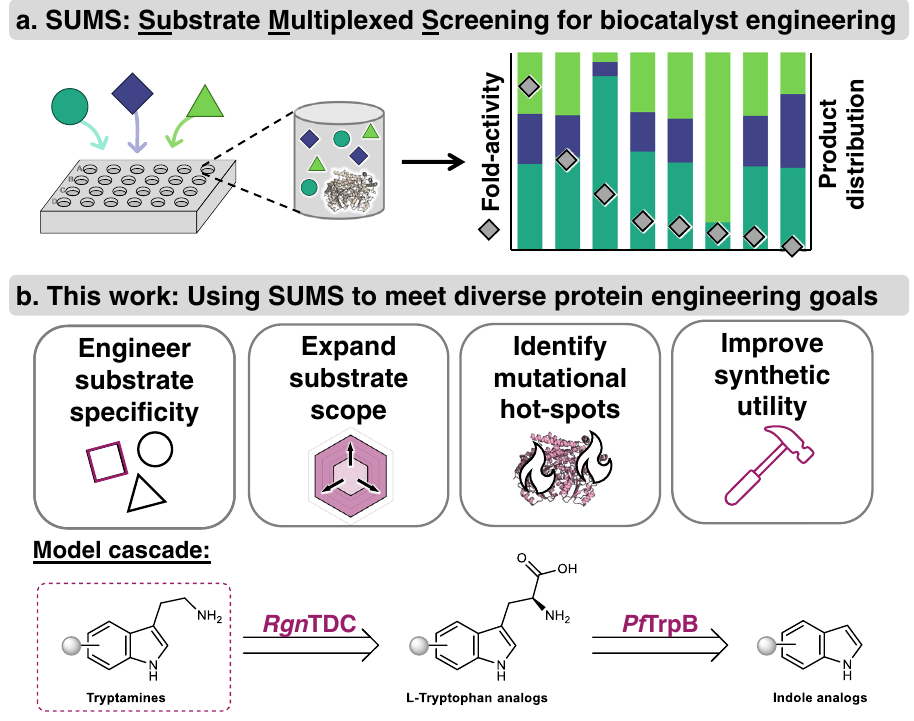
Fig. 1 | Overview ofsubstratemultiplexedscreening (SUMS).a InSUMS,activity is measured for multiple competing substrates simultaneously. b SUMS can be leveragedtoaddressarangeofgoalswhenengineeringbiocatalysts.Here,weapply